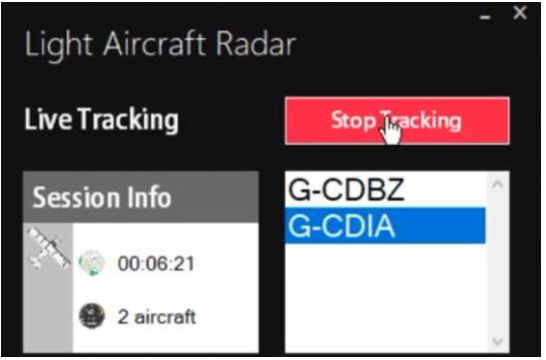
Figure 11. Partial view of the desktop application